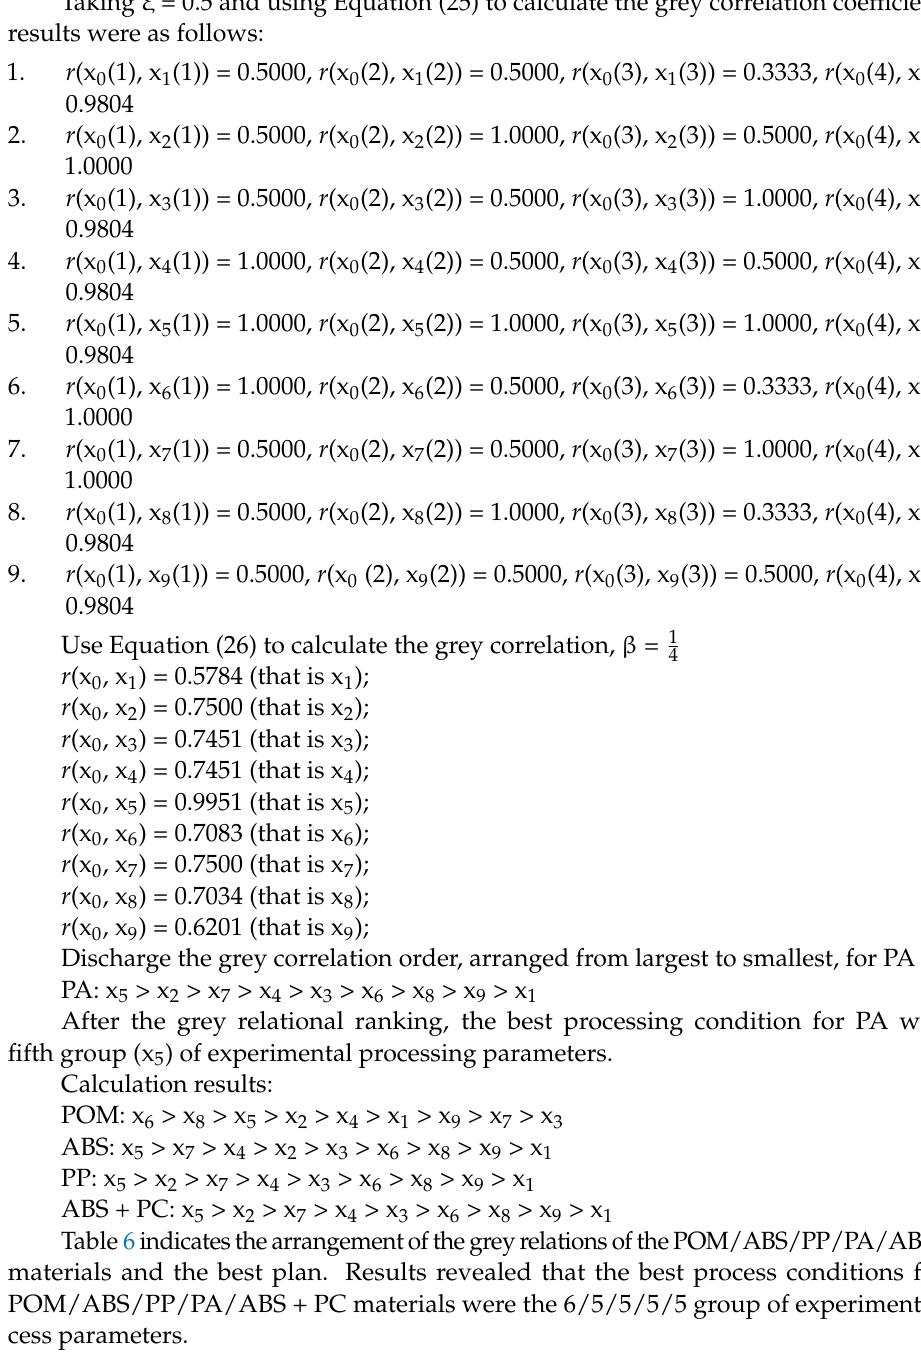
Table 6 indicates the arrangement of the grey relations of the POM/ABS/PP/PA/ABS + PC materials and the best plan. Results revealed that the best process conditions for the POM/ABS/PP/PA/ABS + PC materials were the 6/5/5/5/5 group of experimental pro- cess